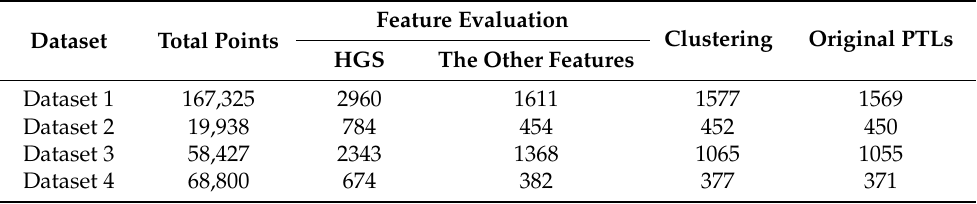
Table 6. Number of residual points after each step with the optimized parameters (unit: thousands).